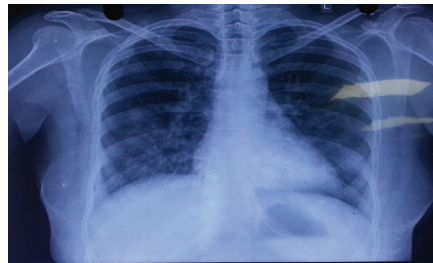
Figure 6: Chest X-ray showing clearance of bilateral interstitial